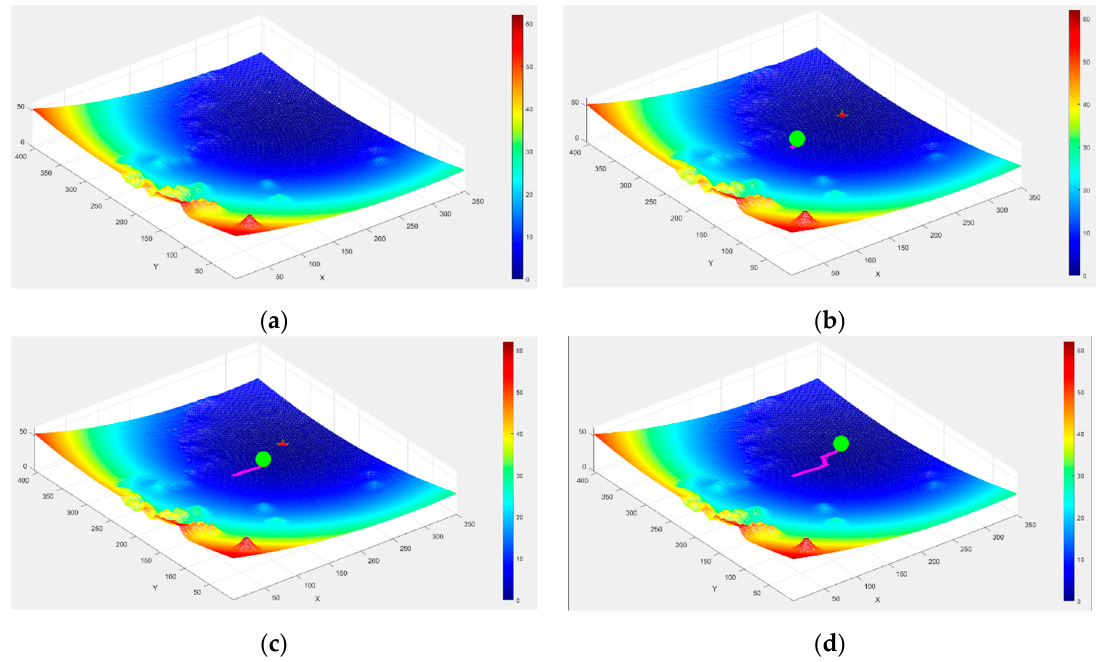
Figure 11. Combination of obstacle potential and DQN-based ship path planning. ( a ) Initial marine environment of obstacle potential; ( b ) Initial position of starting point and target point; ( c ) Model prediction path process; ( d ) Model prediction end of path